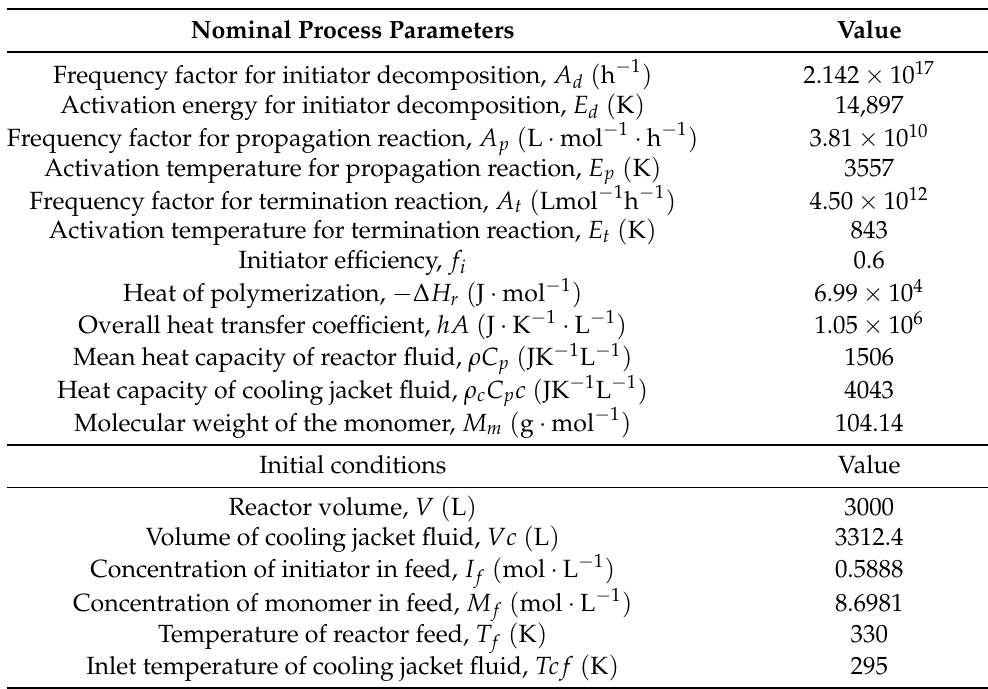
Table 2. Parameters and initial conditions.